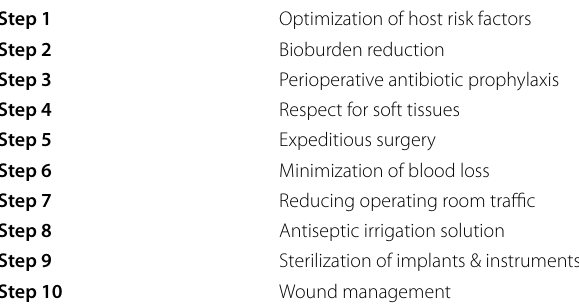
Table 1 Ten steps of SSI/PJI prevention Step 1 Optimization of host risk